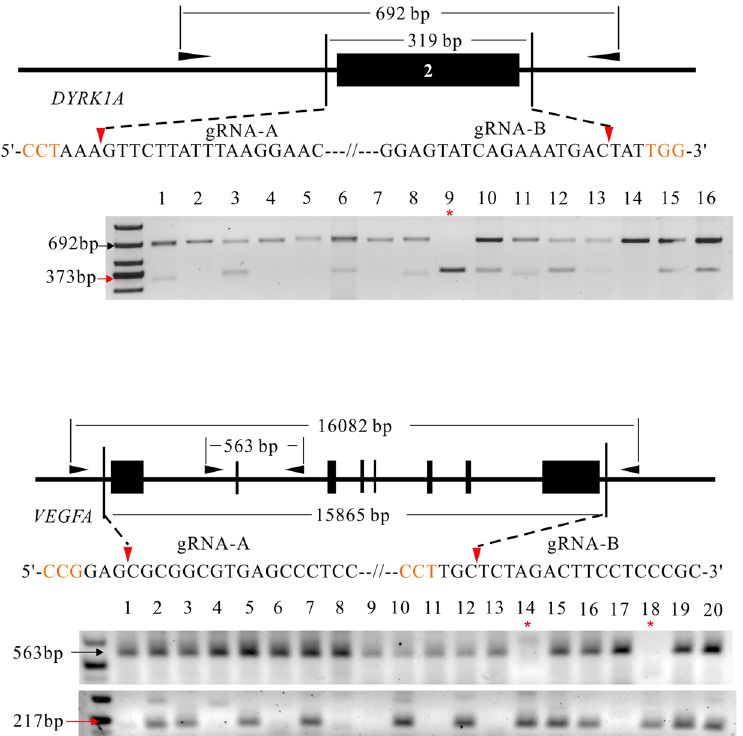
Figure 4. The epiCRISPR system for efficient genomic deletions. ( a ) The strategy for deletion of the 2 nd exon of DYRK1A . A 373-bp PCR band will be present when deletion occurs (indicate by red arrow). A representative gel picture was shown. ( b ) The strategy for deletion of the full-coding sequence of VEGFA . Two pairs of primers were designed. One pair is to detect the non-deletion allele (563-bp) and one pair is to detect deletion events (217-bp, indicate by red arrow). The black triangles indicate the primers for the genotyping PCR reaction. The outer primers work only when deletion occurs. The PAM sequence is shown in orange; the red triangles indicate Cas9 cutting site; red arrows indicate the epiCRISPR-modified PCR bands; black arrows indicate unmodified PCR bands; the red asterisks indicate the homozygous knockout for both